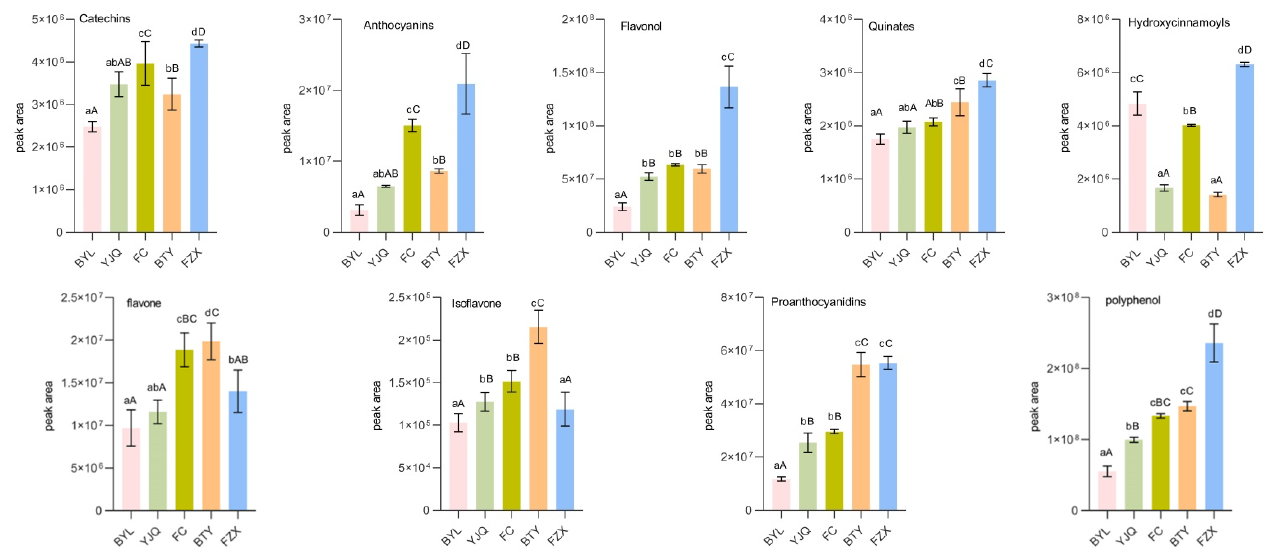
Figure 3. Comparison of polyphenol metabolites in different litchi cultivars. Note: The data of similar category of polyphenol metabolite obtained by summarizing the peak areas of each metabolites of the same kind, total phenols are the sum of phenolic compounds. Small letters means significant differences at the level of 0.05; capital letters means extremely significant differences at the level of 0.01, the same small letters or capital letters mean no significant differences at the level of 0.05 or 0.01.